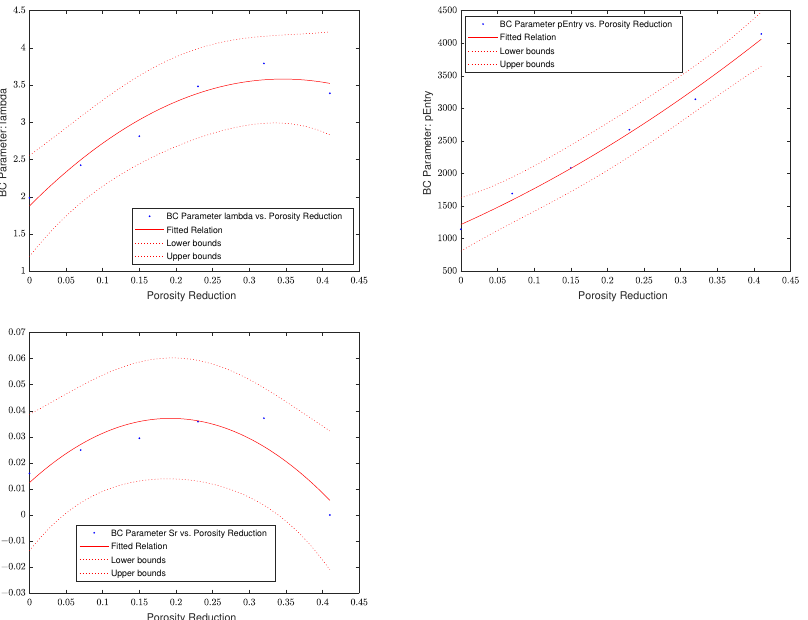
Figure 9. Observed dependency of the Brooks–Corey parameters on the porosity reduction λ ( left ), entry pressure p e ( right ), and residual saturation S r ( bottom ) for Experiment